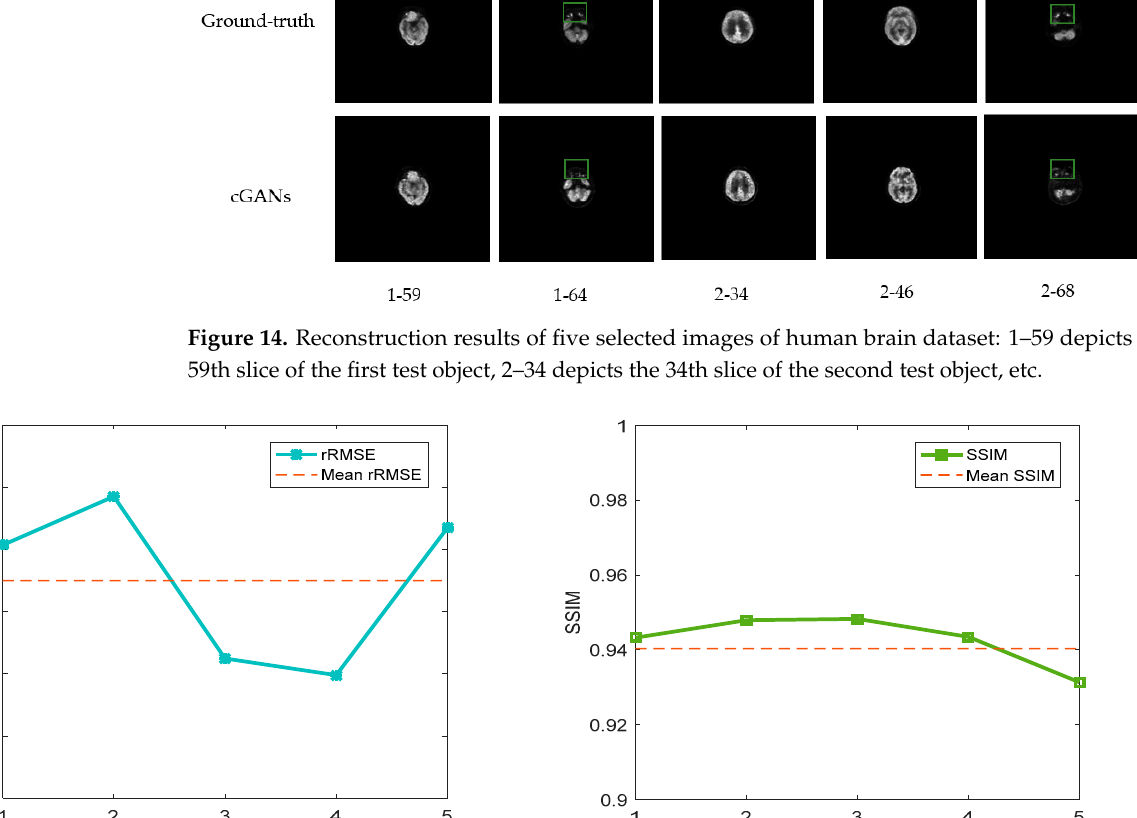
Figure 15. Reconstruction results of five selected images of human brain dataset.